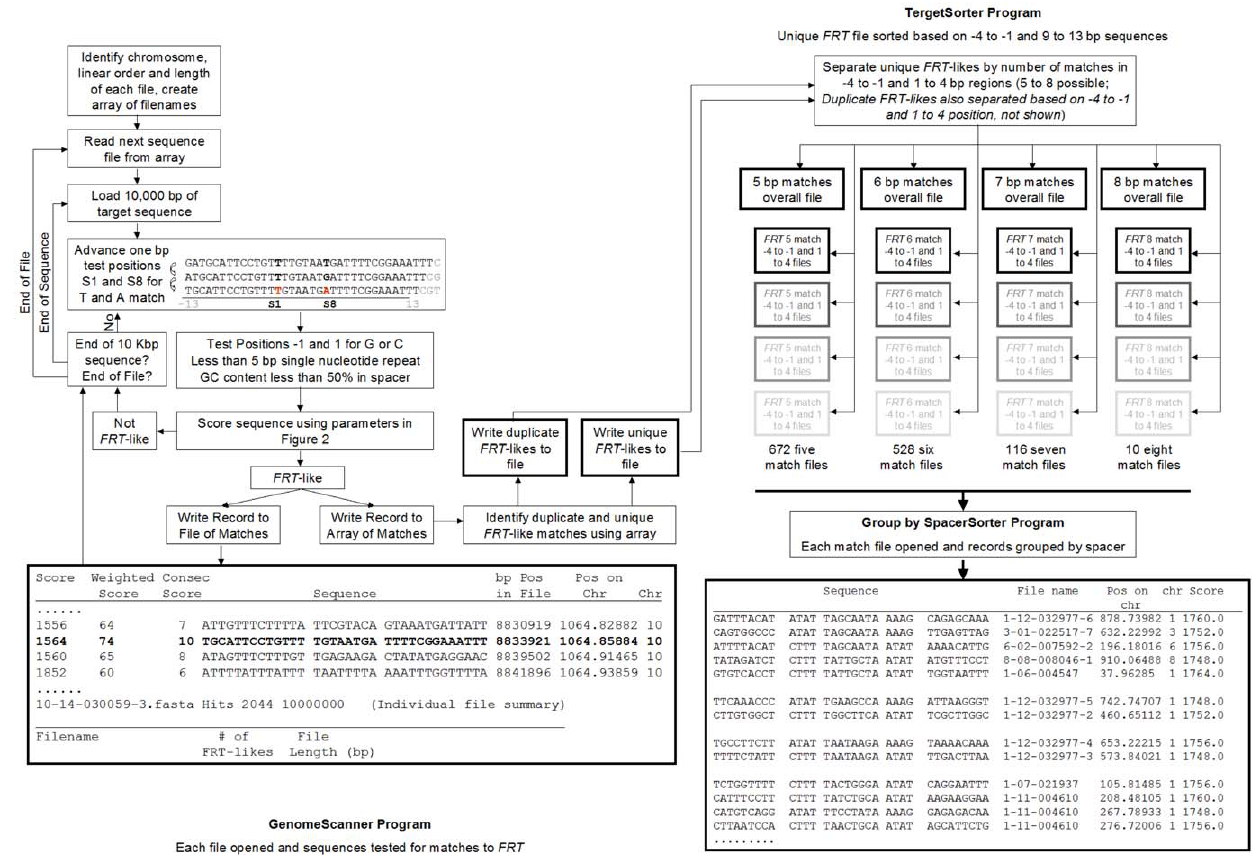
Figure 4. Overview of TargetSiteAnalyzer bioinformatics package used to find FRT -like sequences within 2.8 Gbp of human genomic DNA (NCBI build 36.3). Heavy-bordered boxes indicate the creation of a file. File format boxes may have spaces added for readability in this figure.